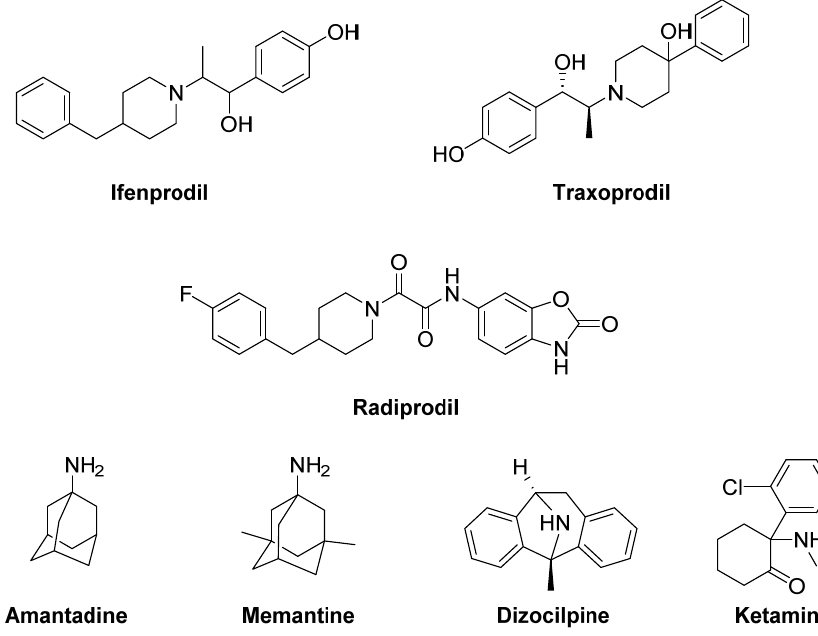
Figure 5. N-methyl-D-aspartate (NMDA) receptor Figure 5. N ‐ methyl ‐ D ‐ aspartate (NMDA) receptor ligands.